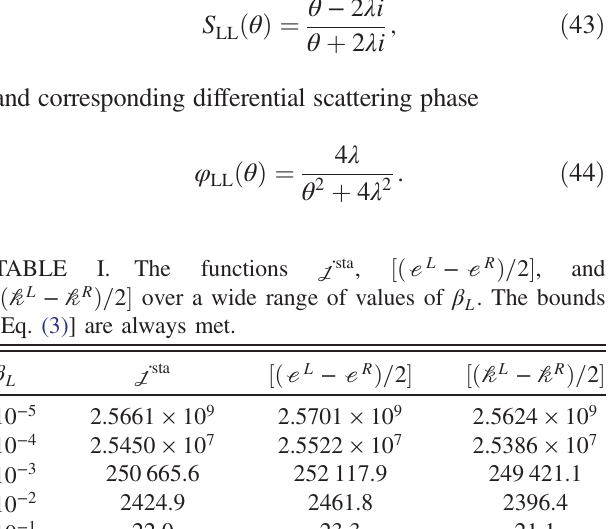
, we observe the collapse F ∈ ½ − 1 ; 1 (cid:3) with F